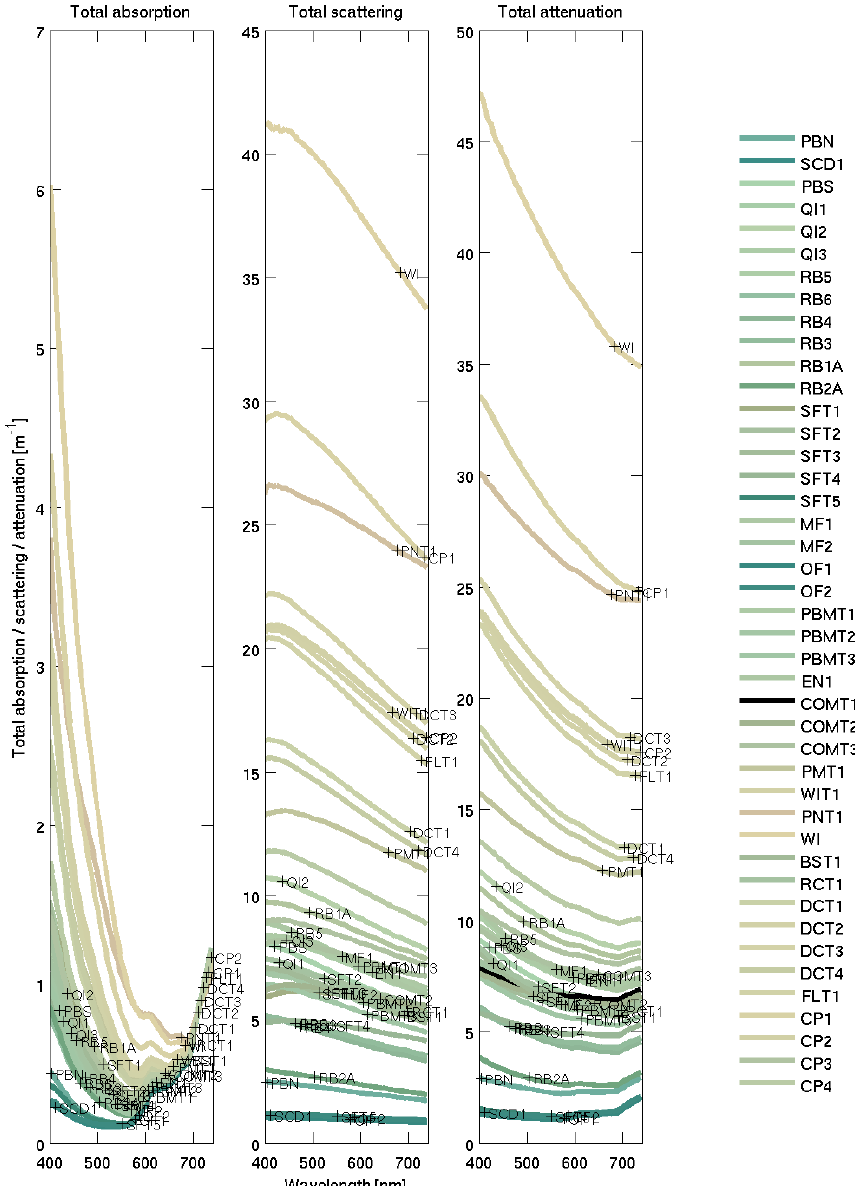
Figure 9. Inherent optical properties (total absorption and total scattering) at sample sites in Gladstone Harbour on 13–19 September 2013 (Babcock et al., 2015). The line colour is rendered like that in Fig. 8. The site labelling is ordered in time, from the first sample collected during neap tides at the top to the last sample collected at spring tides on the bottom. The IOPs used for the Mud non − CaCO from the WIT site (see legend) at the centre of the harbour, was dominated by inorganic particles. The measured concentration of NAP at the site was 33.042mgL − 1 and is used to calculate mass-specific